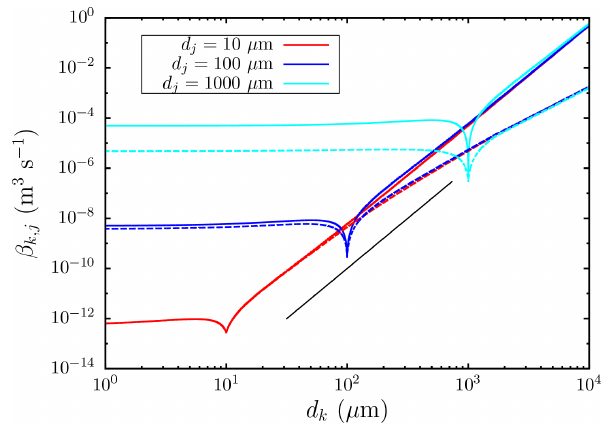
Figure 4. The variation in the collision rate ( β k,j ) between particles as the size of the particle d k varies for three values of d j . The solid lines are calculated with Stokes terminal velocity, and the dashed lines are calculated with the terminal velocity given by Eqs. (29)– (31). The black line is proportional to d 4 k